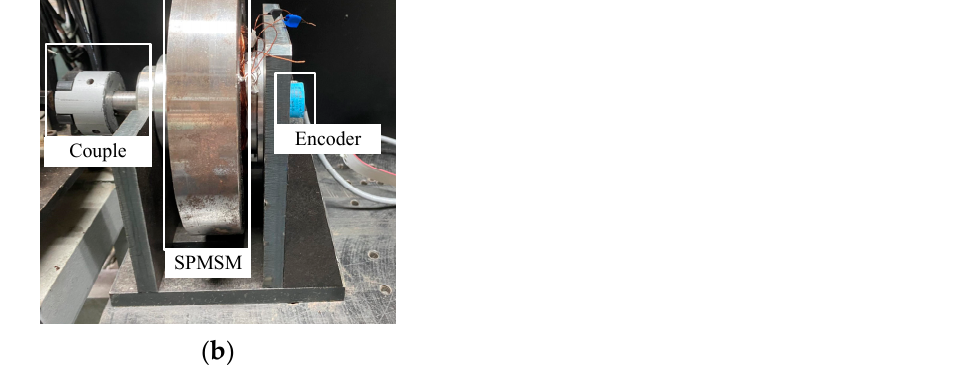
Figure 9. Photographs of the SPMSM drive system. ( a ) motor ( b ) encoder, motor, and coupling connector.